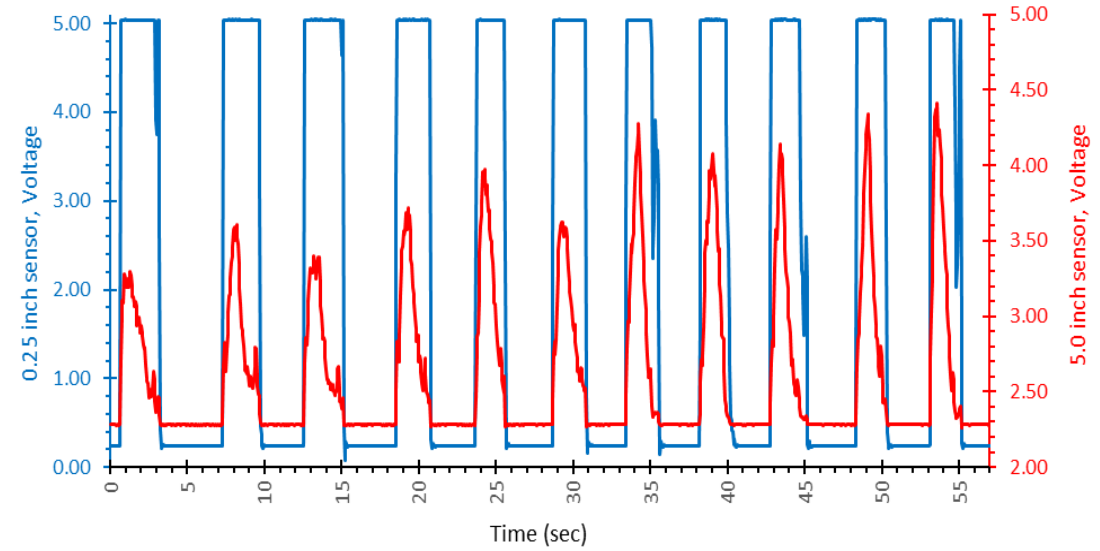
Figure 4. A representative sample plot of sensor voltage ( y -axis) versus time ( x -axis) for 2.00 L challenge puffs conducted at high flow. The left-hand scale (blue) corresponds to the 0.25-inch sensor signal. The right-hand scale (red) corresponds to the 5.0-inch sensor signal. Note the pronounced signal saturation in the 0.25-inch sensor as characterized by the flat-topped peak.